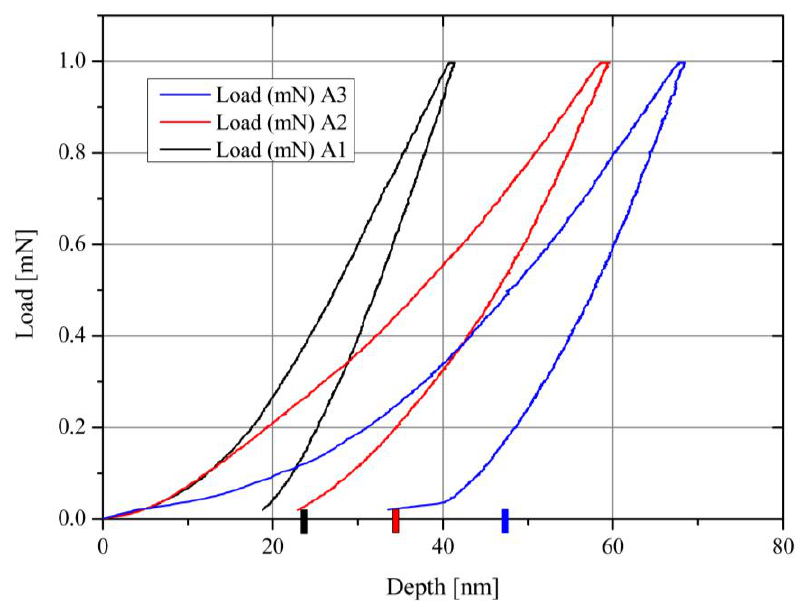
Figure 12. Charge–discharge indentation curves for samples A1, A2, and A3 (Table 1) at a maximum load of 1 mN. Color markers identify the contact depth hc of the indenter at maximum loads. Table 4. Growth rate of the BN phase for the annealed samples at different temperatures in running N 2 . Referent value of H o = 5.39 GPa.